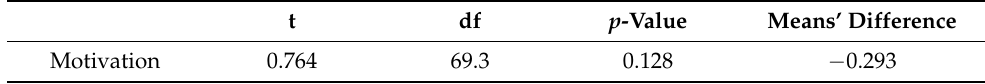
Table 4. Results from the t-test for equality of means (students’